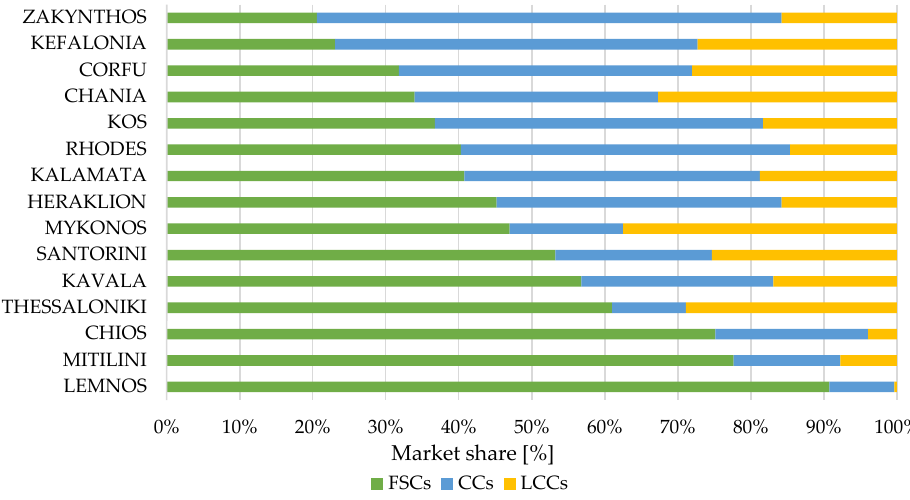
Figure 4. Market share among different airline types in the study airports (2010 – 2016).